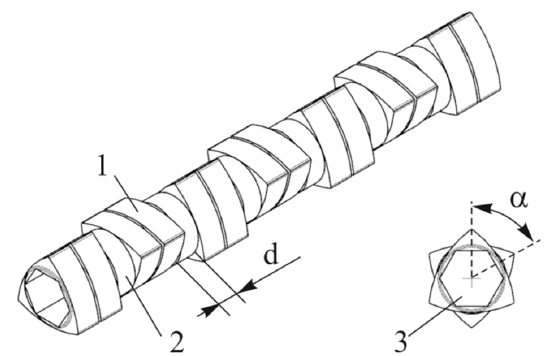
Figure 2. Scheme of the test segment 1—triple-lobe kneading element; 2—spacer; 3—hexagon drill for the screw core; d—distance between kneading elements; α —angle between the kneading elements.